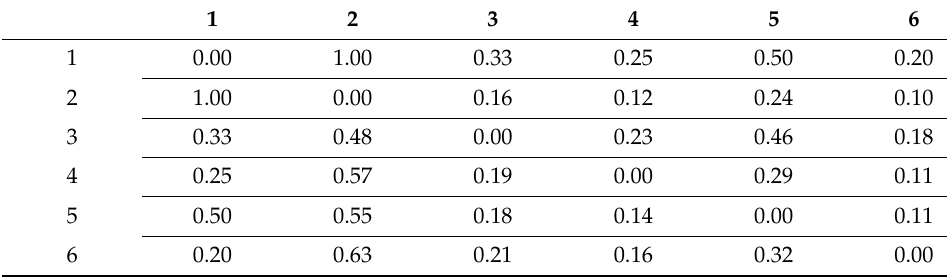
Table A8. ( W (cid:48) ( V )) table.